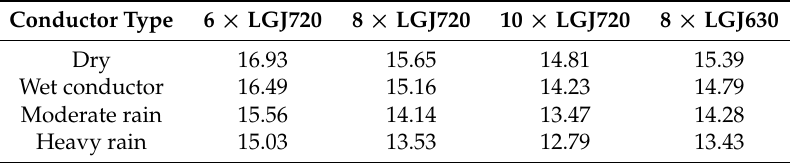
Table 5. Experimental value: the corona onset gradient